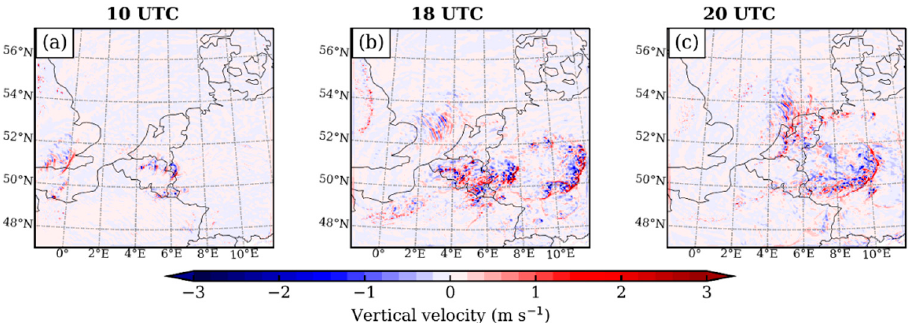
Figure 12. Comparison of the vertical velocity for three different hours, ( a ) 10 UTC (before the lightning event), ( b ) 18 UTC and ( c ) 20 UTC (during the lightning event) on 18 August 2011.